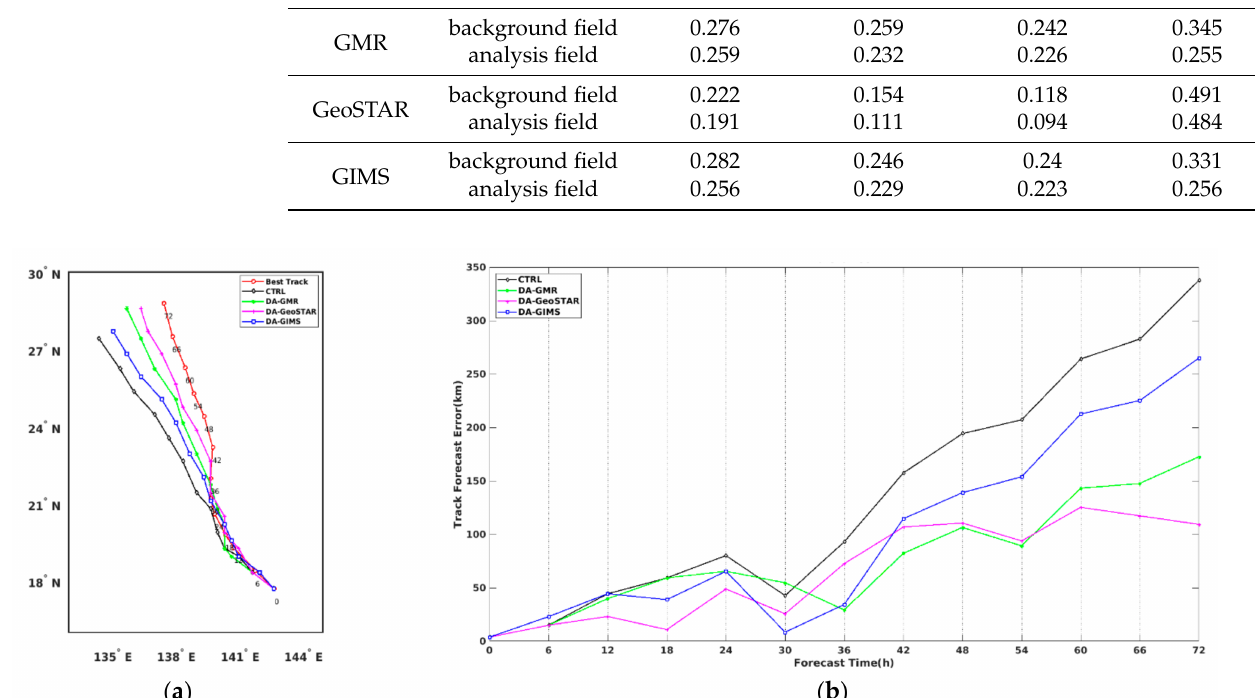
Figure 14. The predicted track of Hagibis initialized from 06:00 UTC on 8 October 2019 ( a ) and track forecast errors ( b ). The red curve in ( a ) represents the best typhoon track